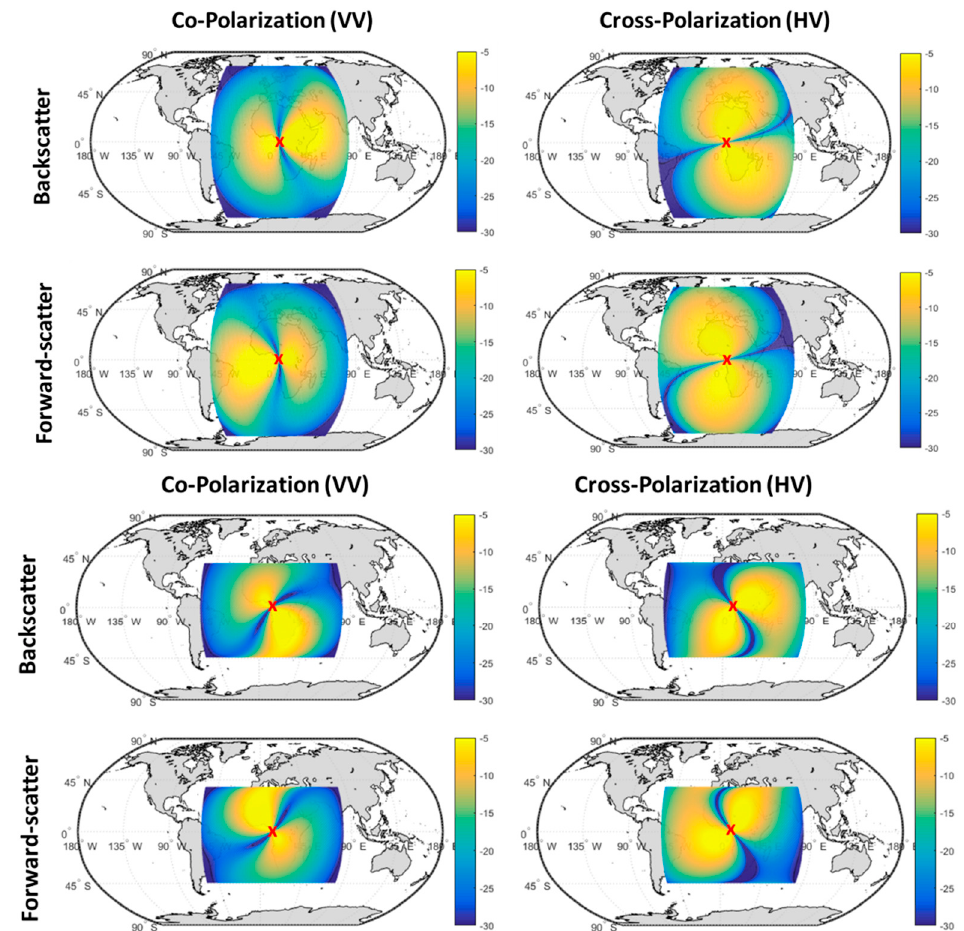
Figure 4. Bistatic backscatter evaluated as function of the geographic position of the LEO-SAR and observed by a GEO-SAR located at 10° E longitude (red cross) according to [10,11], for X-band, ‘soil’. Upper four panels: Polar orbiting LEO-SAR. Lower panels: nearly equatorial orbiting LEO-SAR.